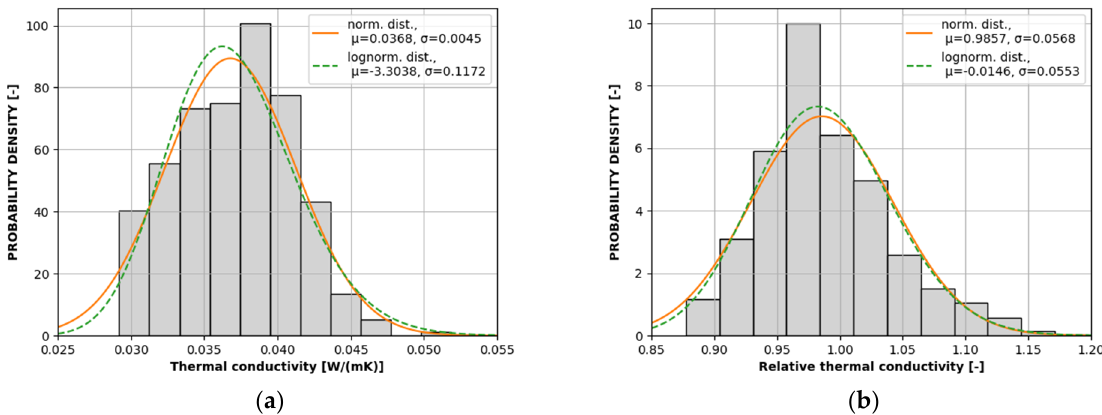
Figure 1. Histograms of: ( a ) measured thermal conductivity and ( b ) relative thermal conductivity, calculated as relation of the thermal conductivity measured to the one declared by the producer.